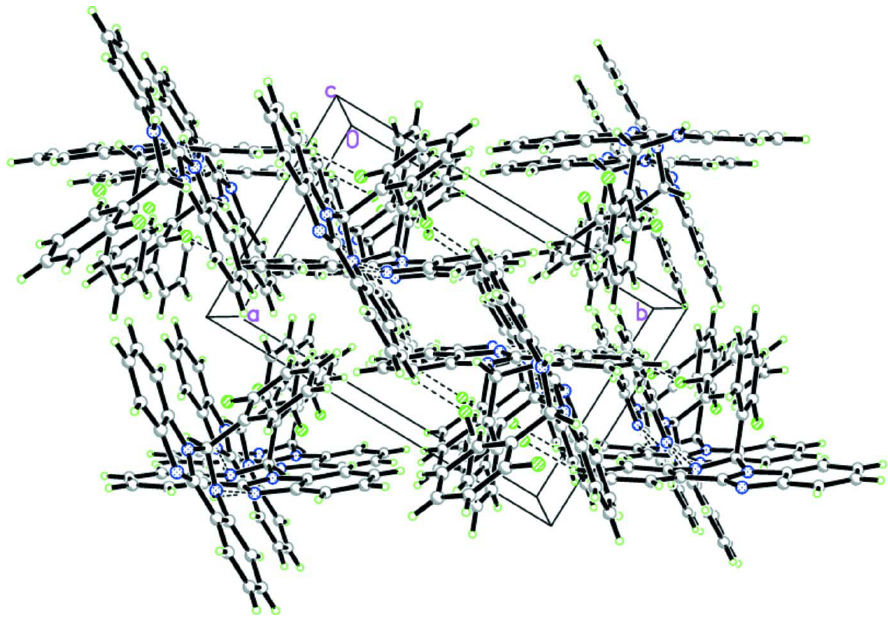
The crystal packing of the title compound, viewed along the c axis. Hydrogen bonds are shown as dashed